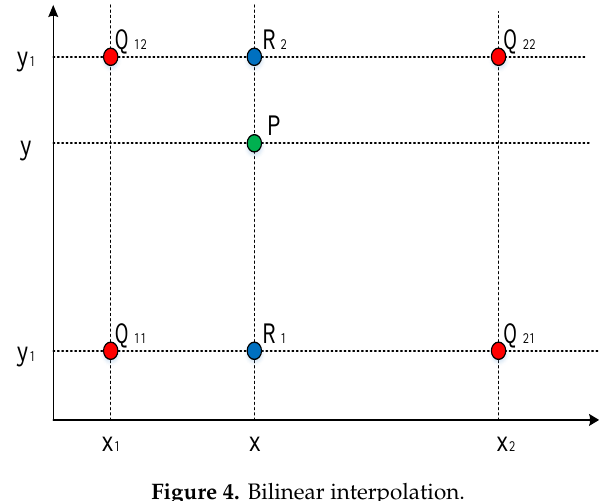
Figure 4. Bilinear interpolation. Figure 4. Bilinear